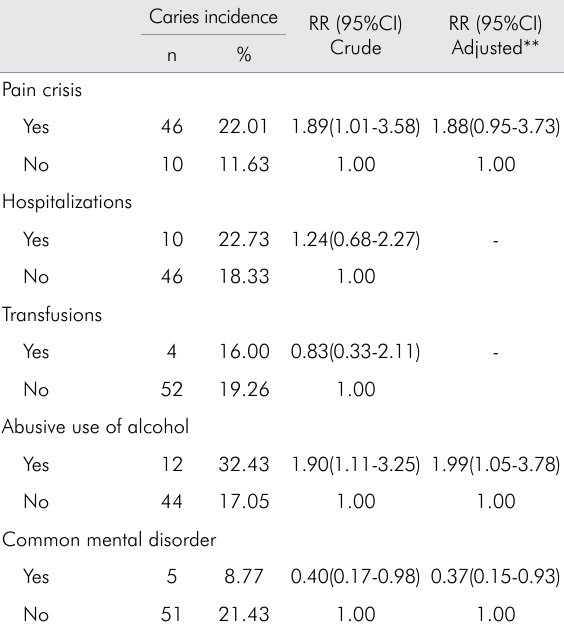
Table 2. Analysis of crude and adjusted risk relative (RR) between caries incidence and severity of clinical variables and maternal risk behavior in children aged 6 to 60 months with sickle cell disease in Bahia (n = 295).